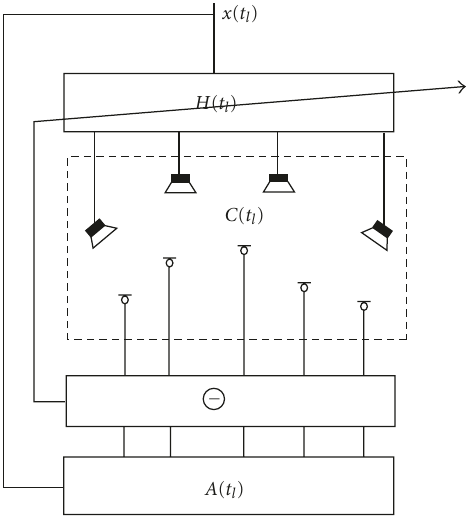
Figure 6: Equalization for sound reproduction.